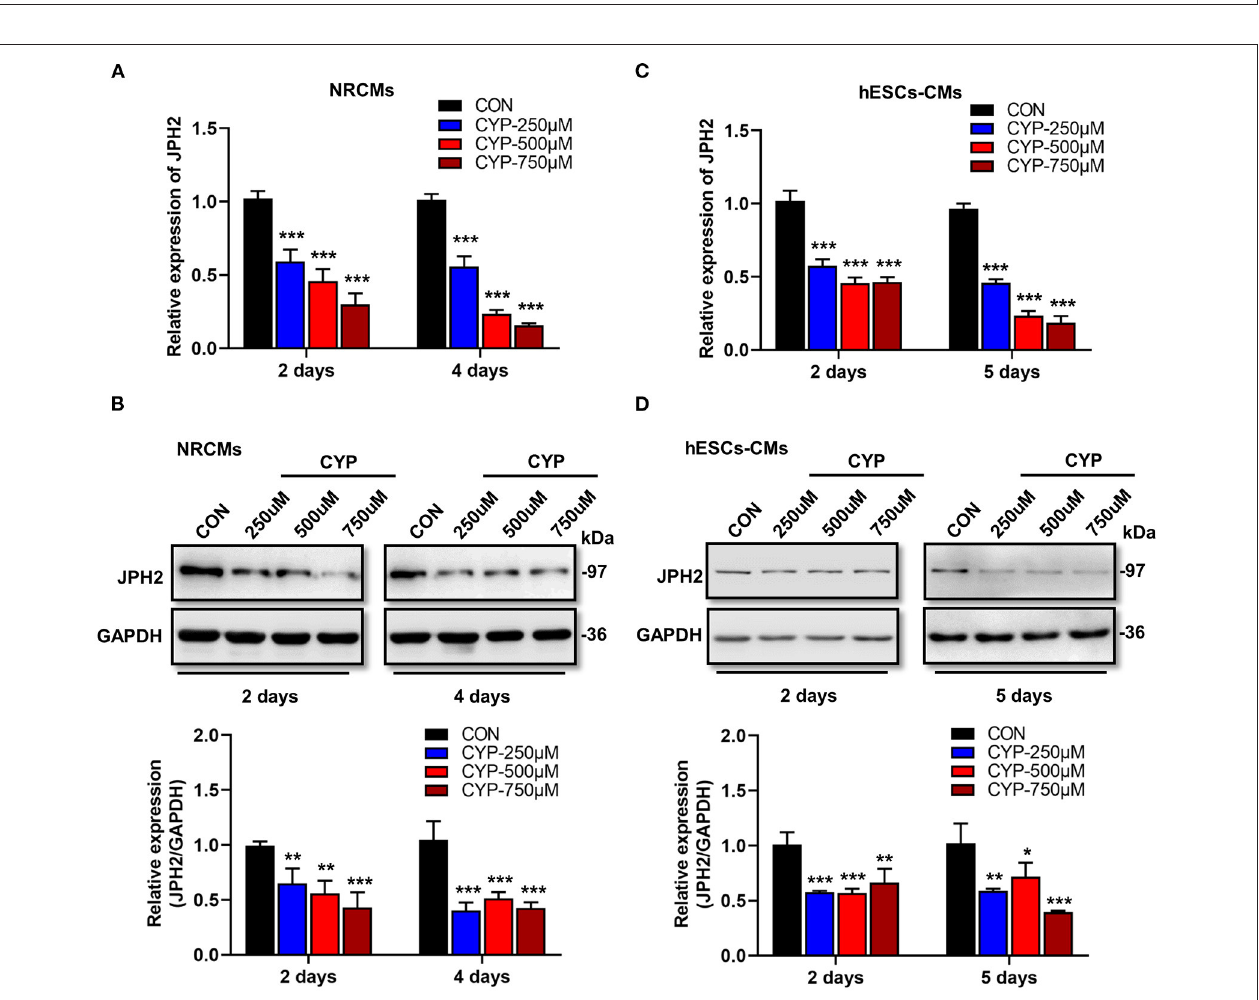
FIGURE 3 | CYP induced the downregulation of JPH2 expression in cardiomyocytes. Real-time PCR (A) and western blot (B) analysis of JPH2 expression in NRCMs treated with CYP for 2 or 4 days. Real-time PCR (C) and western blot (D) analysis of JPH2 expression in hESCs-CMs treated with CYP for 2 or 5 days. The data are shown as the mean ± SE of three experiments. * P < 0.05, ** P < 0.01, *** P < 0.001 vs.